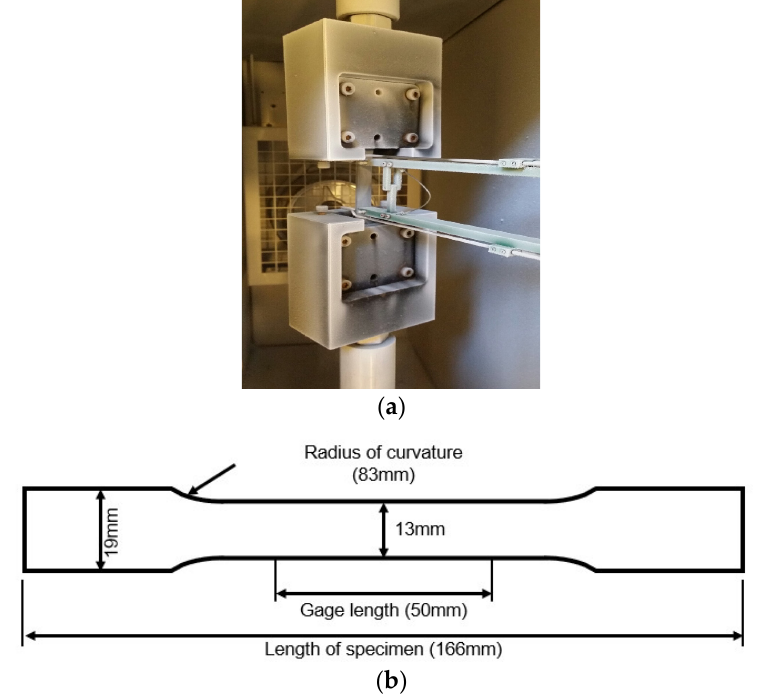
Figure 2. ( a ) Photographs of the tensile test in a cryogenic environment and ( b ) shape and dimensions of the specimen.